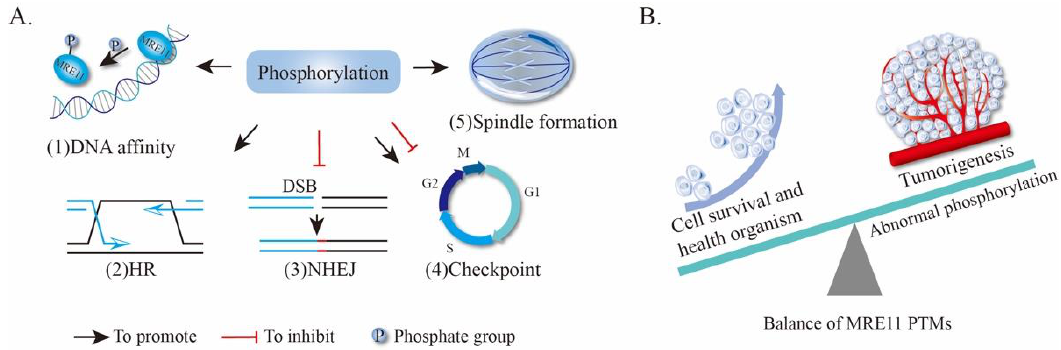
Figure 4. The effect of MRE11 phosphorylation. ( A ) The effect of MRE11 phosphorylation on DNA affinity, HR, NHEJ, cell cycle checkpoint, and spindle formation. ( B ) Abnormal phosphorylation induces tumorigenesis. HR, homologous repair; NHEJ, non-homologous end-joining; DSB, DNA double-stranded break.